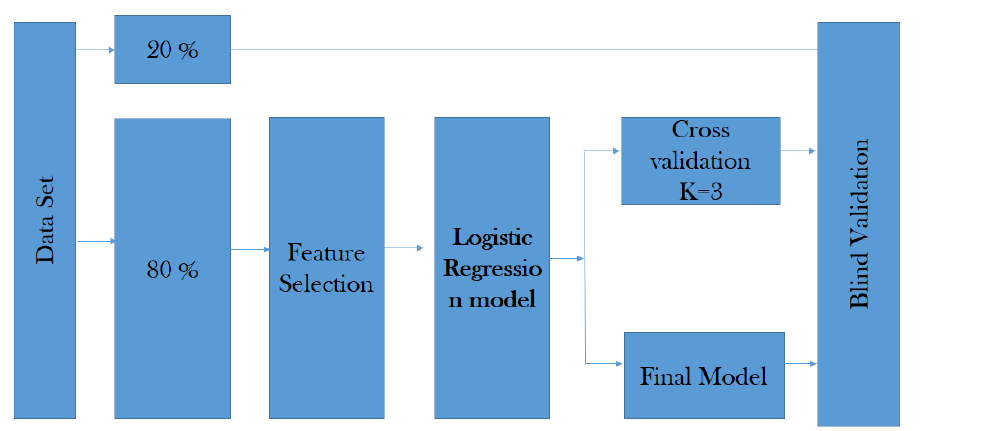
Figure 8. Proposed validation